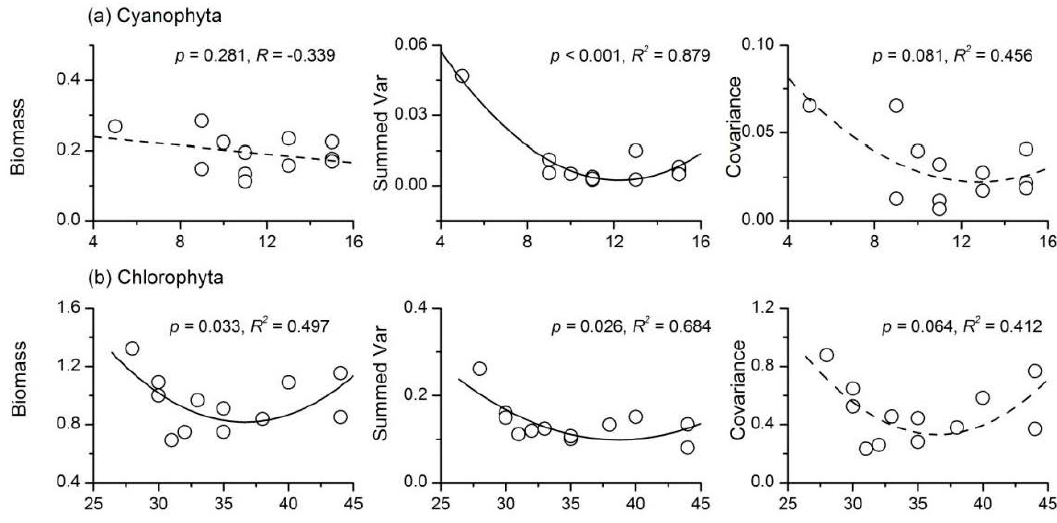
Figure 5. Diversity ‐ stability relationships of ( a ) Cyanophyta; ( b ) Chlorophyta; ( c ) Bacillariophyta; ( d ) Euglenophyta and ( e ) total phytoplankton.